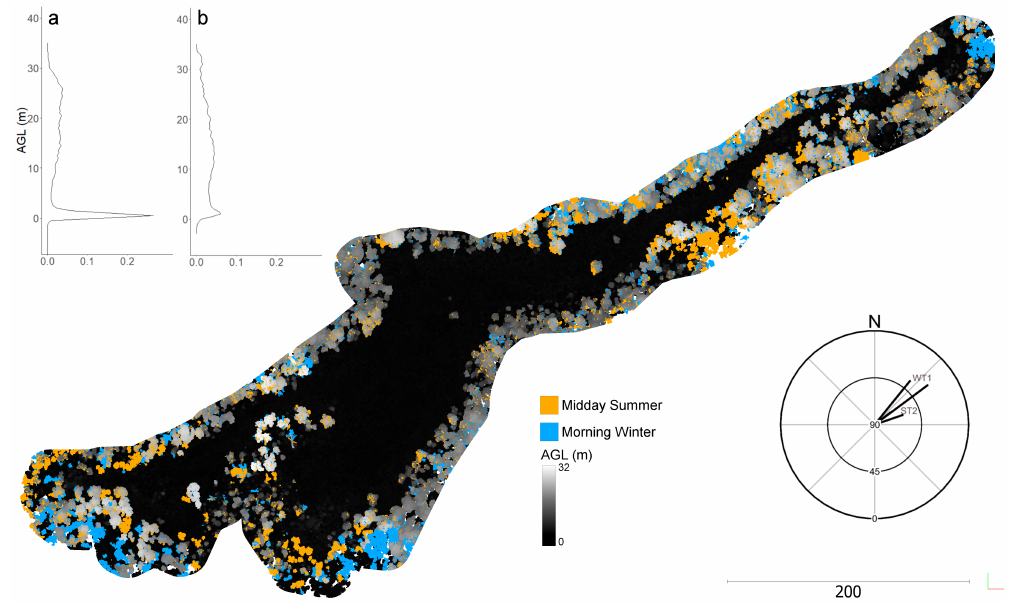
Figure 14. (main) Dense point cloud reconstruction of features separated by < 0.5 m in both products combined and displayed as a height ramp. Dense points > 10 m AGL that are uniquely reconstructed are shown projected so that the highest AGL points are visible. Elevations for all products are calculated as z distance component from a red point cloud 2 m z minimum subsample to remove underlying terrain. The relative frequency of uniquely reconstructed point features for ( a ) ST2 and ( b )